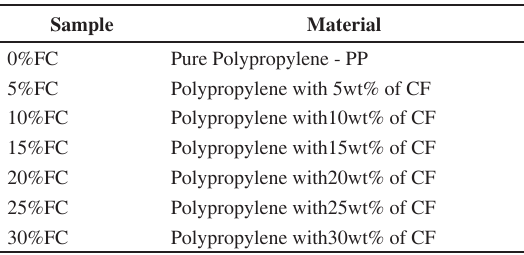
Figure 2. Physical aspect of the mat at different steps of the composites preparation. a) Raw mat; b) Box-shaped mat; and c) PP-Fiber composite injected. Table 1. Specimens composition based on filler